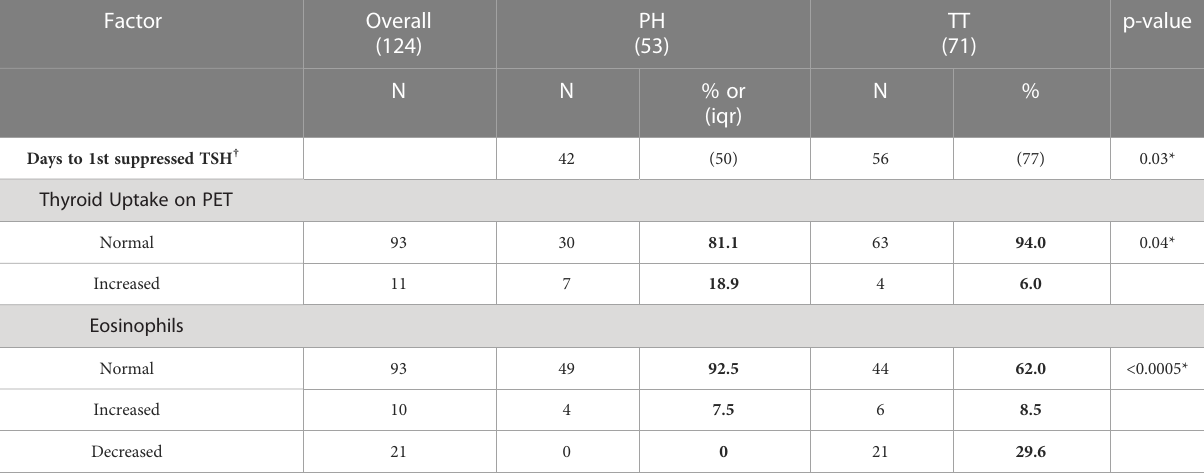
TABLE 2B Clinical parameters in PH vs